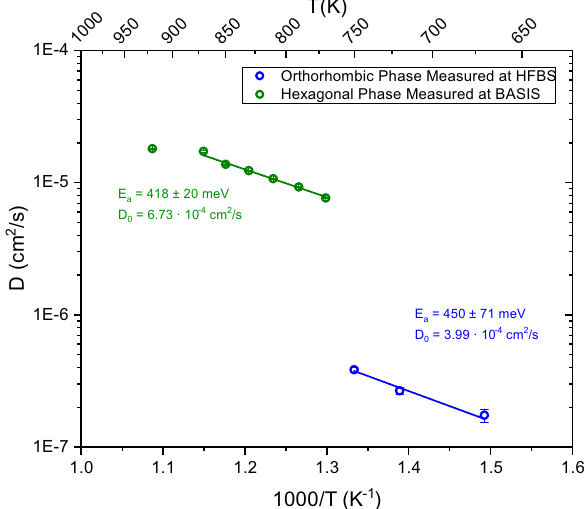
Figure 6. Arrhenius diagram for BaH 2 corresponding to diffusion coefficients calculated from experimental QENS data at BASIS and HFBS. Solid lines are a linear fit of the data. Activation energies and preexponential diffusion coefficients are